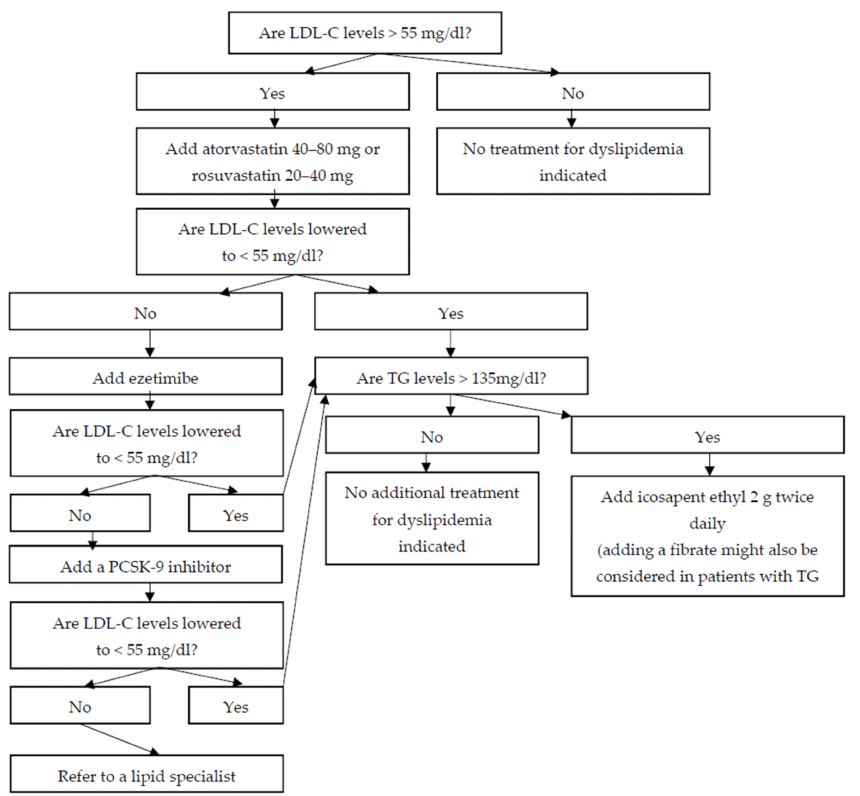
Figure 1. A proposed algorithm for the management of dyslipidemia in patients with a history of ischemic stroke (LDL-C: low-density lipoprotein cholesterol; TG: triglycerides; PCSK-9: proprotein convertase subtilisin/kexin type